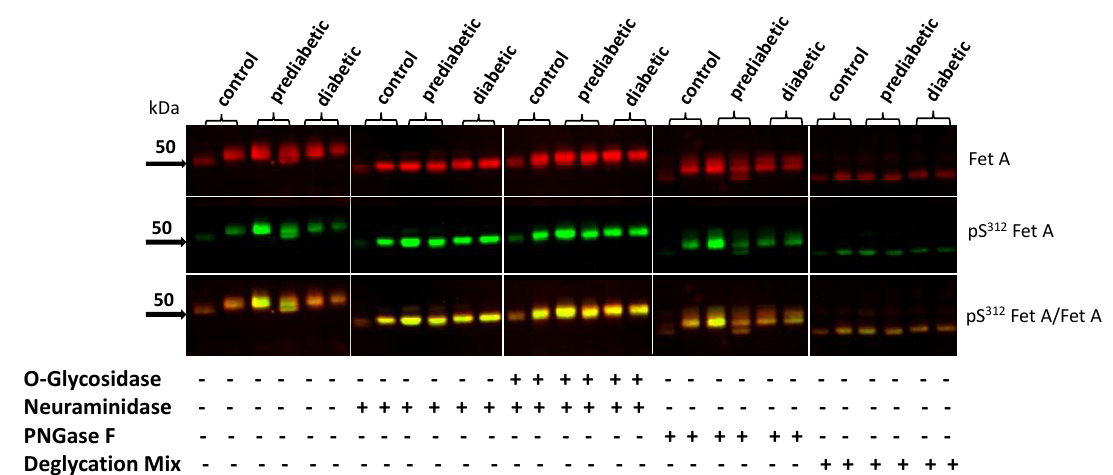
Figure 4. Deglycosylation of Fet A from control, prediabetic, and diabetic patients and effect on Ser 312 Fet A phosphorylation. Serum sample from control, prediabetic and diabetic patients (two of each) were analyzed untreated or treated with the deglycosylation enzymes as indicated. Samples were analyzed for Fet A, pFet A, and overlay by Western blotting as described in the Methods section; bold arrows indicate molecular weight markers.